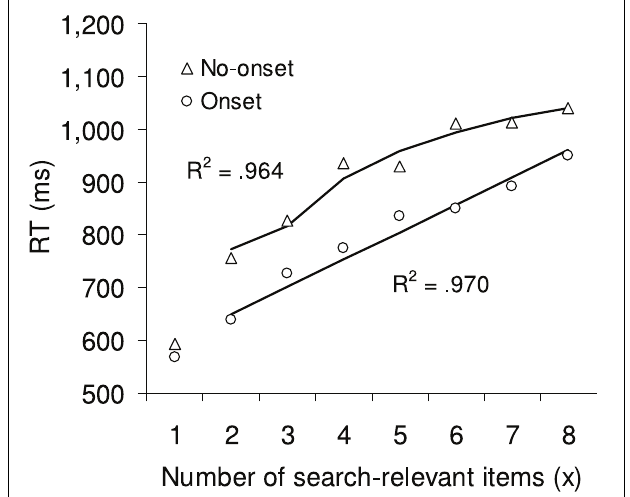
FIGURE 5 | The symbols show the mean correct RTs for no-onset and onset targets in Experiment 3. The lines and R2 show the best fit from a multiple regression analysis (excluding the level with one search relevant item), predicting RT based on the 3-tag model.